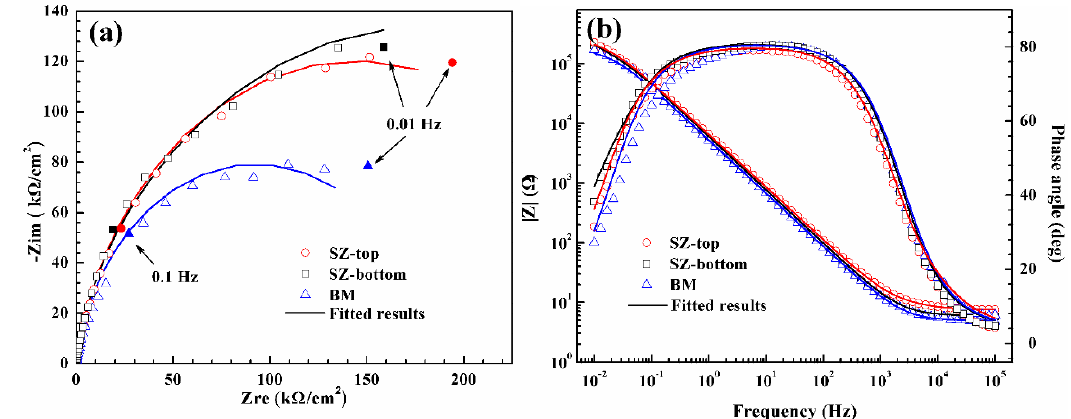
Figure 12. EIS spectrum of BM, SZ-top and SZ-bottom in 3.5 wt. % NaCl solution at 25 °C ± 0.5 °C: ( a ) Nyquist plots; ( b ) Bode plots. Table 2. Equivalent circuit parameters for BM, SZ-top and SZ-bottom in 3.5 wt. % NaCl solution at 25 °C ± 0.5 °C.